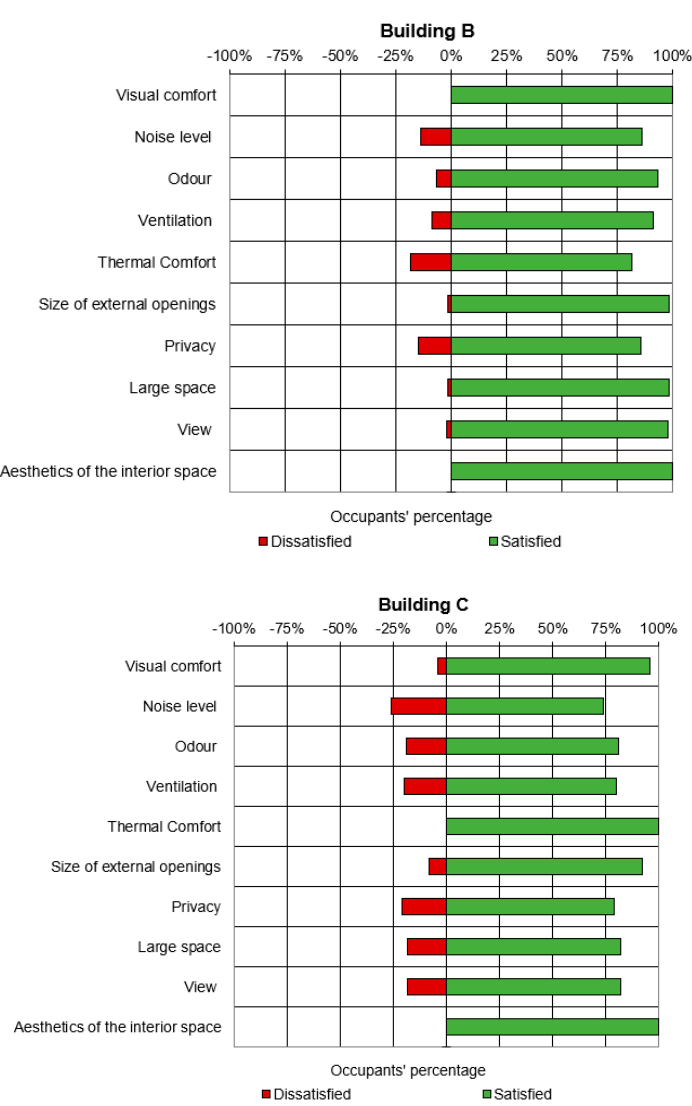
Figure 9. Satisfaction (green color) and dissatisfaction (red color) of different parameters (Visual comfort, Noise level, Odor, Ventilation, Thermal Comfort, Size of external openings, Privacy, Large space, View, Aesthetics of the interior space) for the examined buildings.